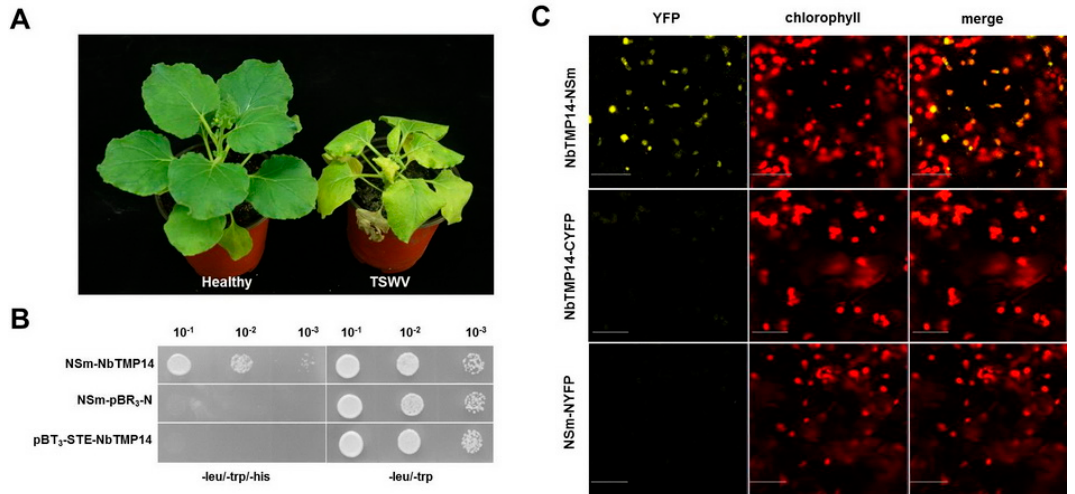
Figure 1. Identification of tomato spotted wilt virus (TSWV) NSm interacting with TMP14 protein in Nicotiana benthamiana . ( A ) Symptoms of TSWV-infected N. benthamiana , 15 dpi. ( B ) Verification of NbTMP14 interacting with NSm though the yeast two-hybrid system. ( C ) Interaction between NbTMP14 and NSm was investigated by BiFC in leaves of N. benthamiana . Scale bars represent 100 μ m.